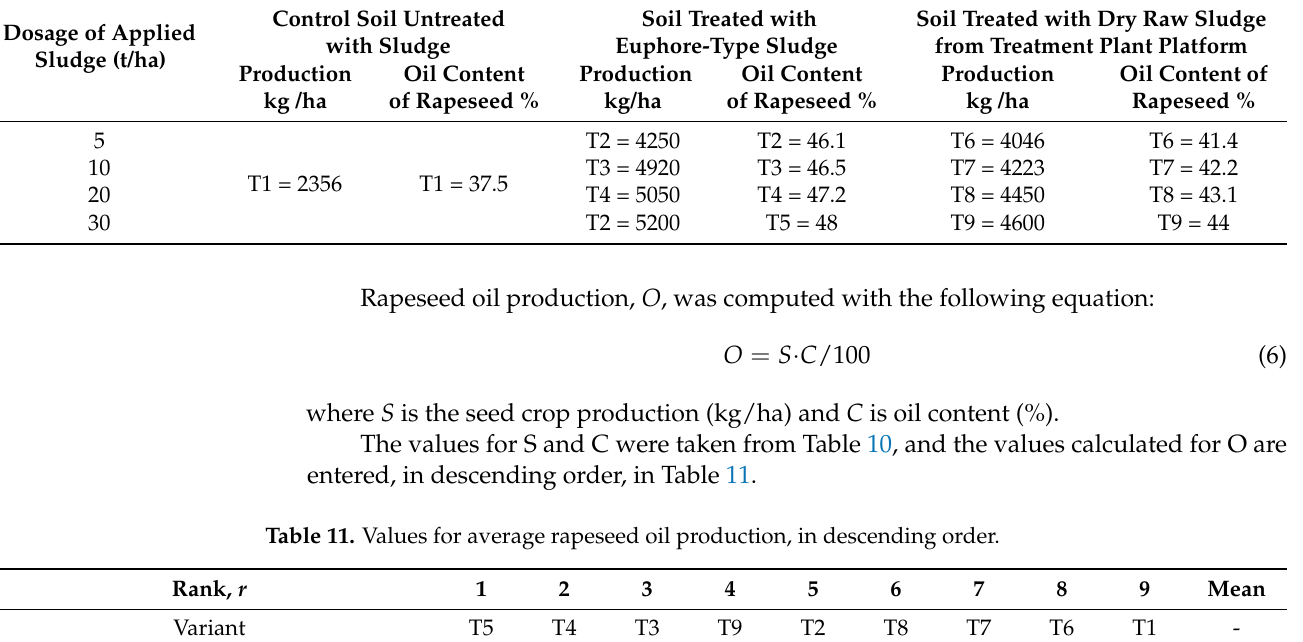
Table 10. Average crop production and oil content of the rapeseed.